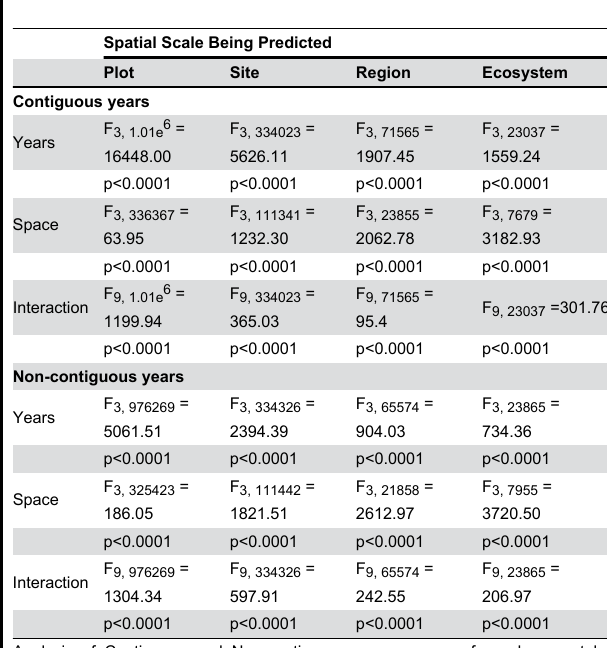
Table 1. F and p-values of profile analysis for contiguous and non-contiguous year